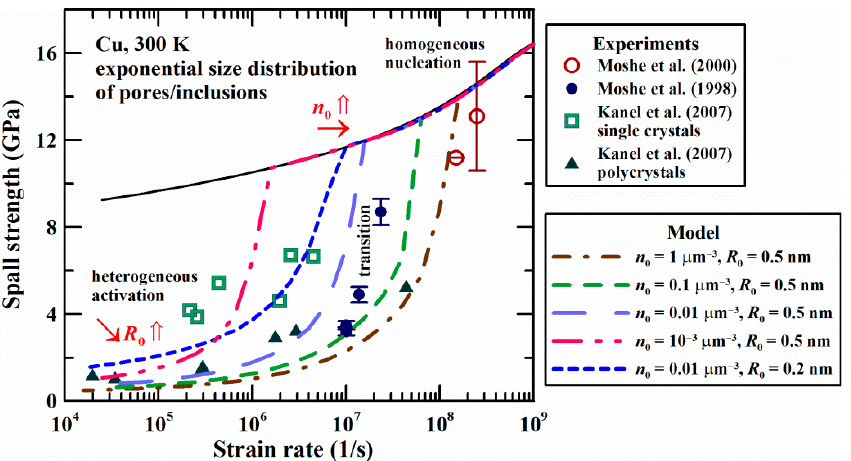
Figure 8. Influence of initial pores or non-wettable inclusions with an exponential size distribution on the strain rate dependence of the spall strength of copper at room temperature; model results in comparison with the experimental data of Moshe et al. (1998) [15], Moshe et al. (2000) [16], and Kanel et al. (2007) [18].